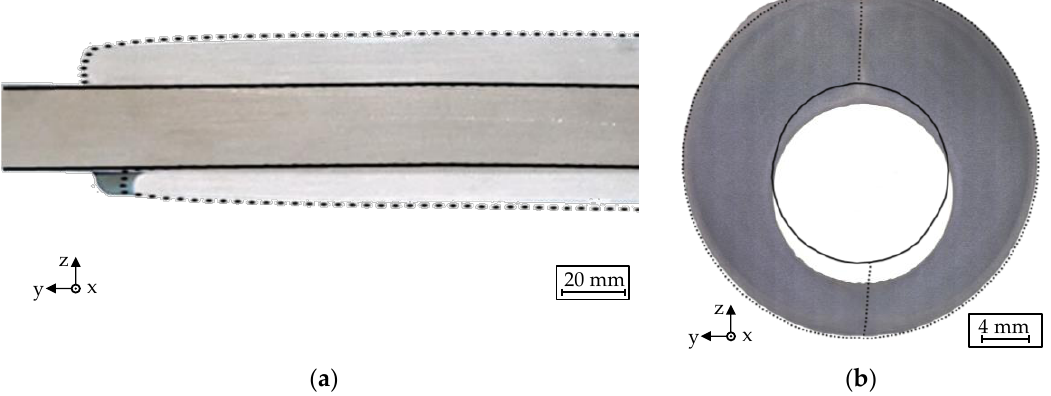
Figure 11. Geometrical comparison between the simulated contour and experimental results for a ram speed of 2 mm·s −1 . The outer contour of the extruded aluminum component is represented by the black dotted line, the outer contour of the steel rod by the continuous black line: ( a ) Longitudinal view; ( b ) Cross-section at a distance of 230 mm behind the tip of the aluminum component.